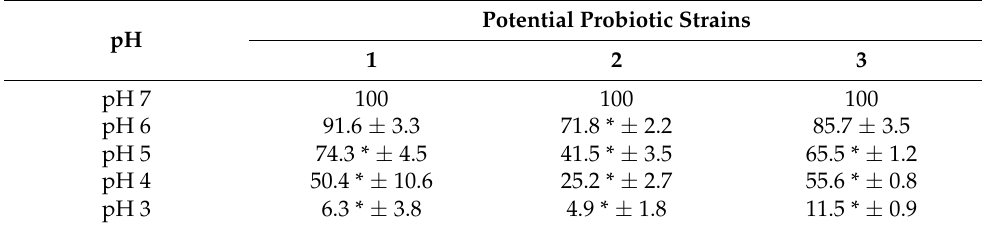
Potential Probiotic